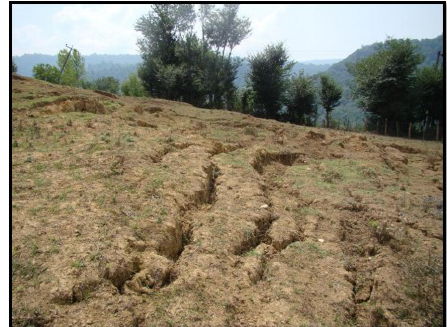
Figure 2: A landslide-prone area with tensile cracks in the northwest-southeast